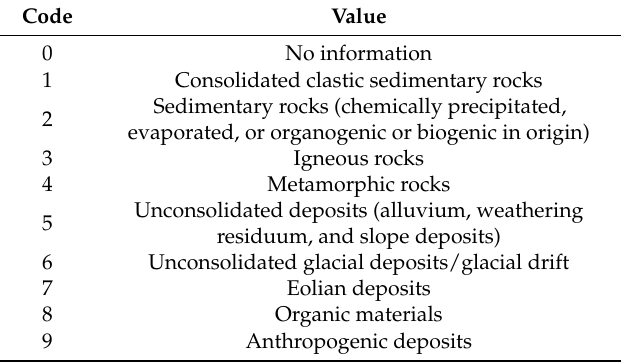
Table 1. Soil Geographical Database (SGDBE) values PARMADO1: Major group code for the dominant parent material.